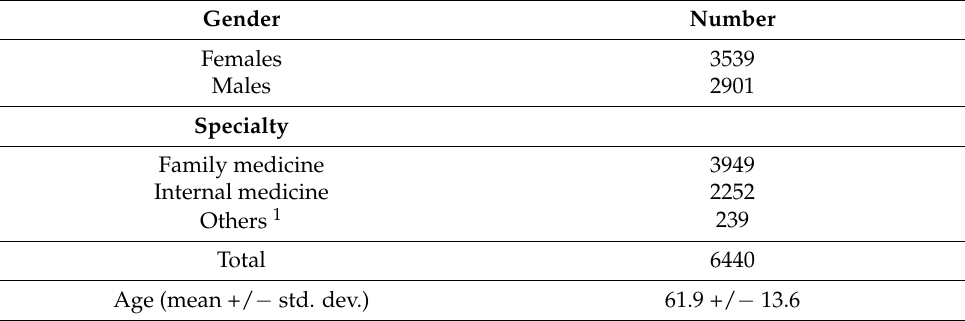
Table 1. Description of cardiovascular cases.